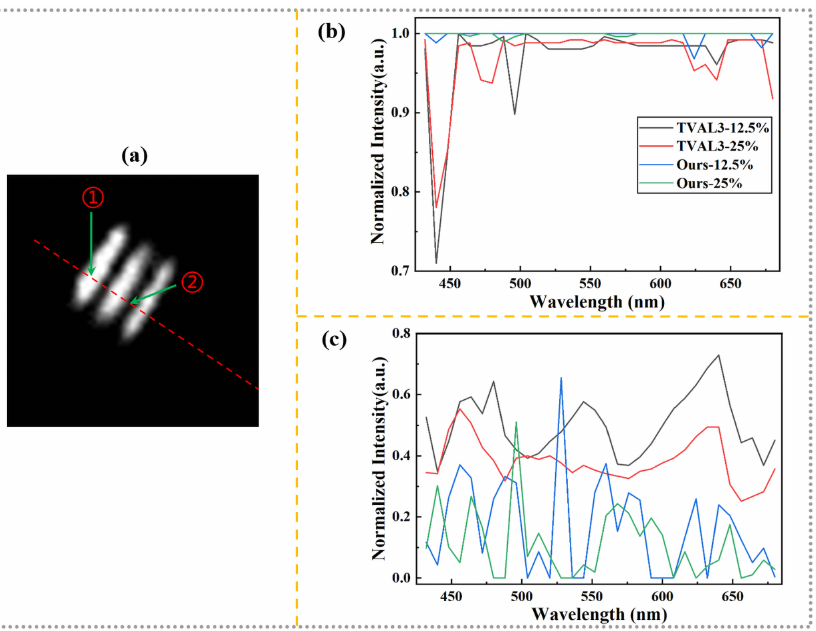
Figure 6. Quantitative analysis results of the hyperspectral imaging. ( a ) Two particular pixels posi- tions are selected along the red dotted line for the reconstruction images obtained by the two methods at different SR and wavelengths, respectively. ( b , c ) The results of the two methods obtained at differ- ent wavelengths and SR in the pixels (cid:172) and (cid:173) , respectively. The black, red, blue, and green curves represent the results of TVAL3 and the proposed method at the SR of 12.5% and 25%,